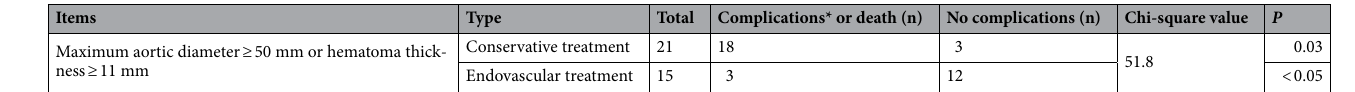
Table 6. Comparison of conservative and endovascular treatment for maximal aortic diameter ≥ 50 mm or hematoma thickness ≥ 11 mm. *Progression of aortic dissection, pseudoaneurysm, rupture, visceral arterial perfusion, lower limb ischemia.